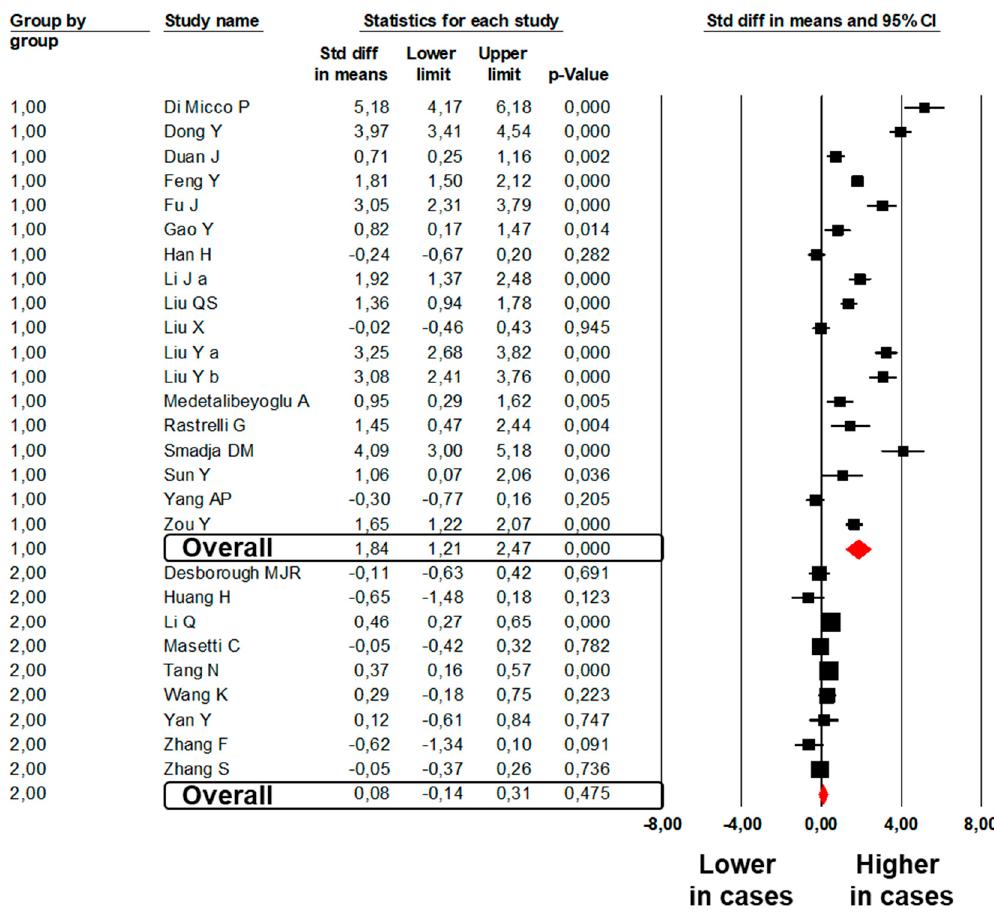
Figure 5. Forest plots of the difference in fibrinogen values between subjects with severe and those with mild COVID-19 (Group 1) and between non-survivors and survivors to COVID-19 (Group 2).